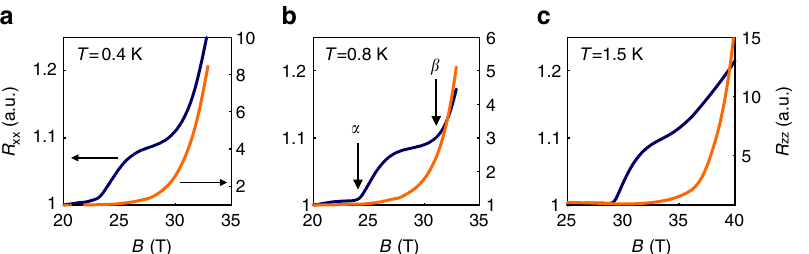
Fig. 3 In-plane and c -axis magnetoresistance in Kish graphite. In-plane ( R xx in blue) and c -axis ( R zz in orange) data obtained at a 0.4 K, b 0.8 K, and c 1.5 K. The magnetic fi eld is oriented along the c -axis. For clarity the curves are normalized to their values at B = 20 T for a , b and B = 25 T for c